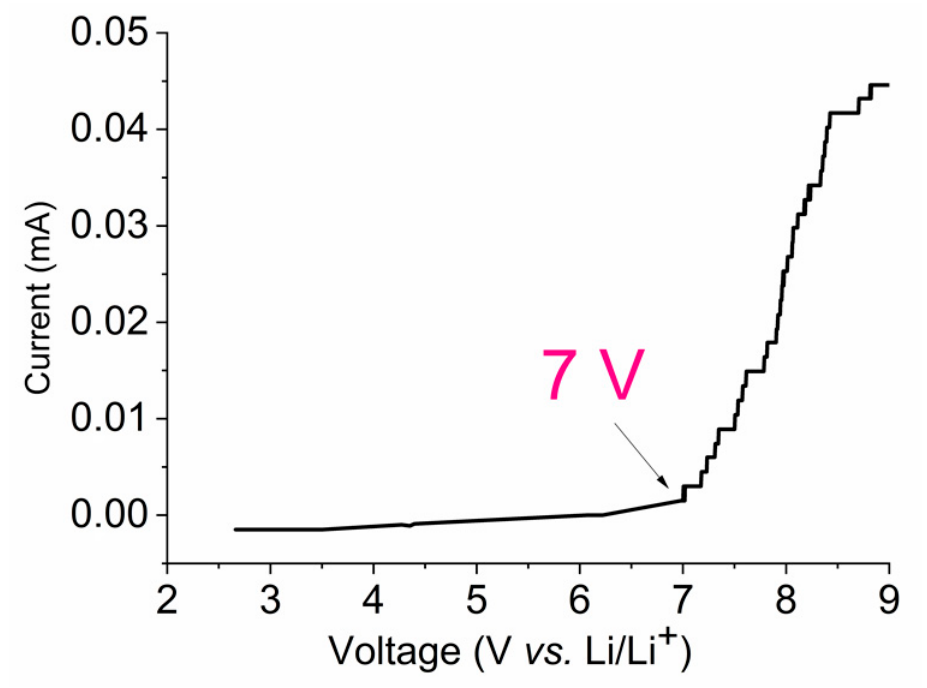
Figure 3. Voltammogram of Li/PGE/Stainless Steel at 2 mV/s rate scanning with PEDA:EC (1:1 w / w ) and LiClO 4 7.5 wt %.